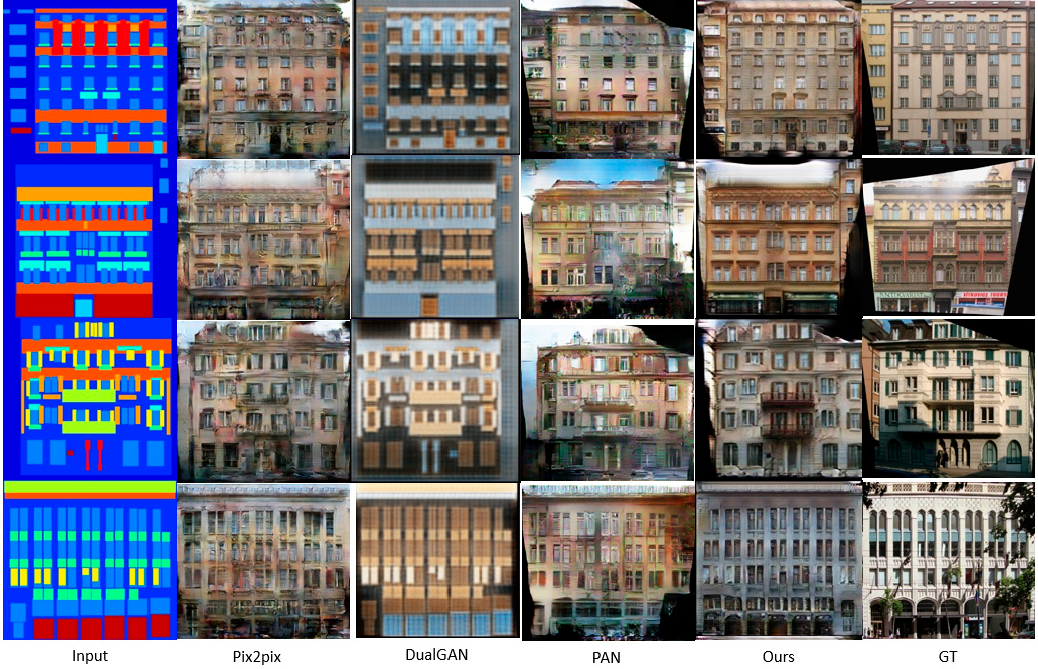
Figure 4. Comparison of the label → facade with Pix2pix, Dual-GAN, and PAN.